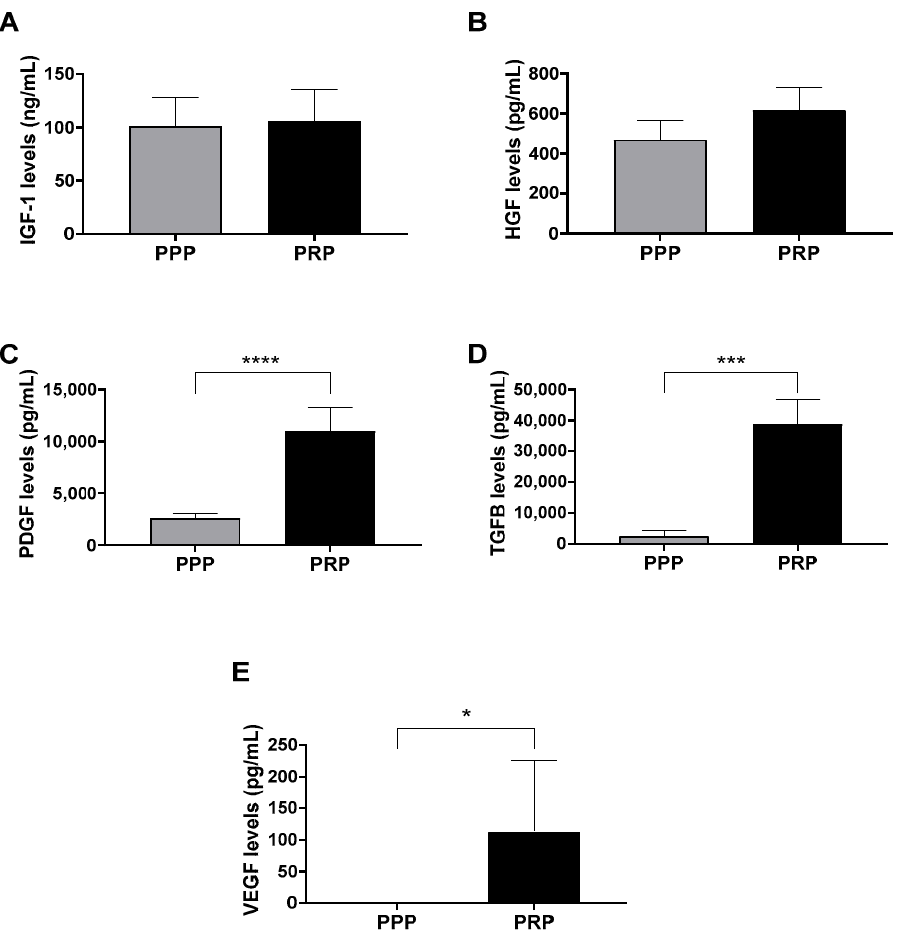
Figure 1. Growth factor levels in lysates after the activation of platelet-poor plasma (PPP) and platelet-rich plasma (PRP). ( A ) Insulin-like growth factor 1 (IGF-1), ( B ) hepatocyte growth factor (HGF), ( C ) platelet-derived growth factor (PDGF), ( D ) transforming growth factor beta (TGF- β ), and ( E ) vascular endothelial growth factor (VEGF) protein levels were measured in duplicate by enzyme- linked immunosorbent assay (ELISA) in the PRP and PPP lysates. Any statistical significance of the differences between PPP and PRP was determined by t -test (* p < 0.05; *** p < 0.001; **** p < 0.0001) ( n = 5).